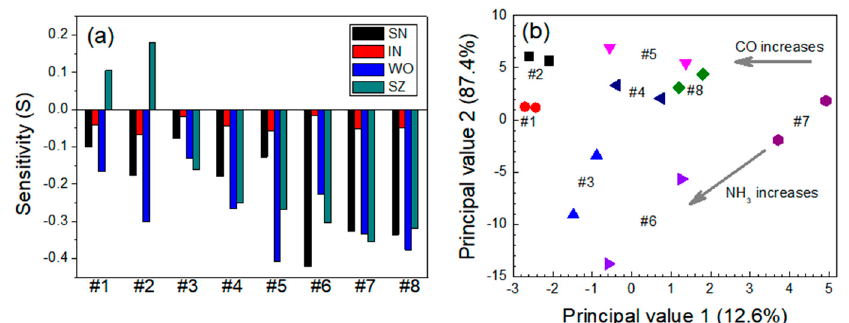
Figure 7. ( a ) Responses of the sensors and ( b ) PCA ‐ based dual ‐ gas sensor monitoring for the CO ‐ NH 3 system. Note that #1–#8 represent 30 ppm CO + 0 ppm NH 3 , 60 ppm CO + 0 ppm NH 3 , 0 ppm CO + 5 ppm NH 3 , 30 ppm CO + 5 ppm NH 3 , 60 ppm CO + 5 ppm NH 3 , 0 ppm CO + 10 ppm NH 3 , 30 ppm CO + 10 ppm NH 3 , and 60 ppm CO + 10 ppm NH 3 , respectively.